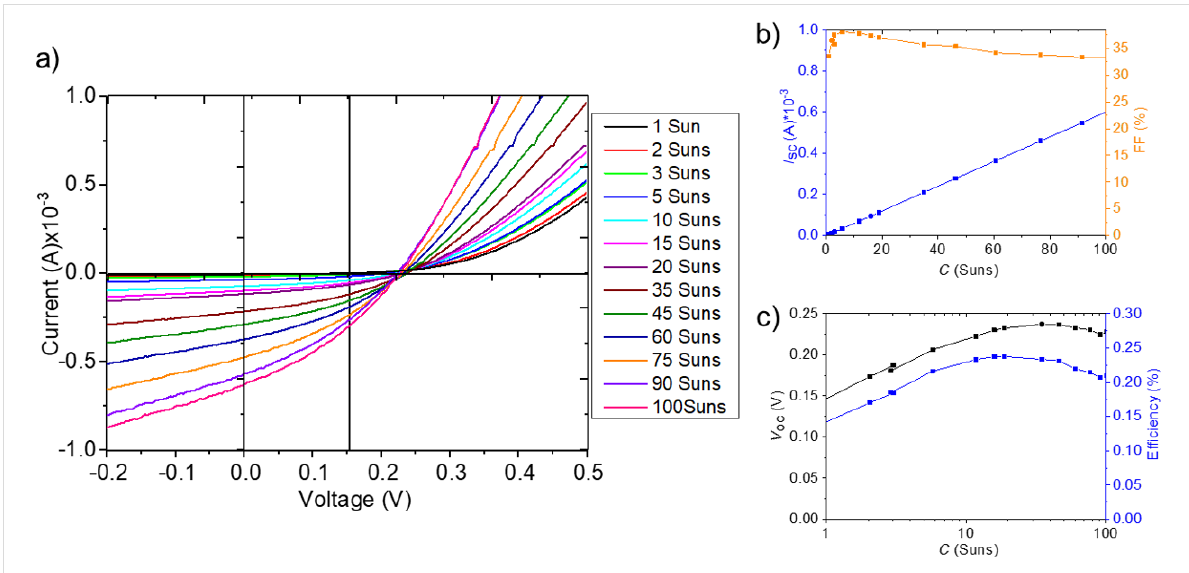
Figure 16: Electrical characterization under various light concentration factors for CIGSe micro cell from LIFT approach: a) IV curves, b) I SC and FF, c) V OC and η